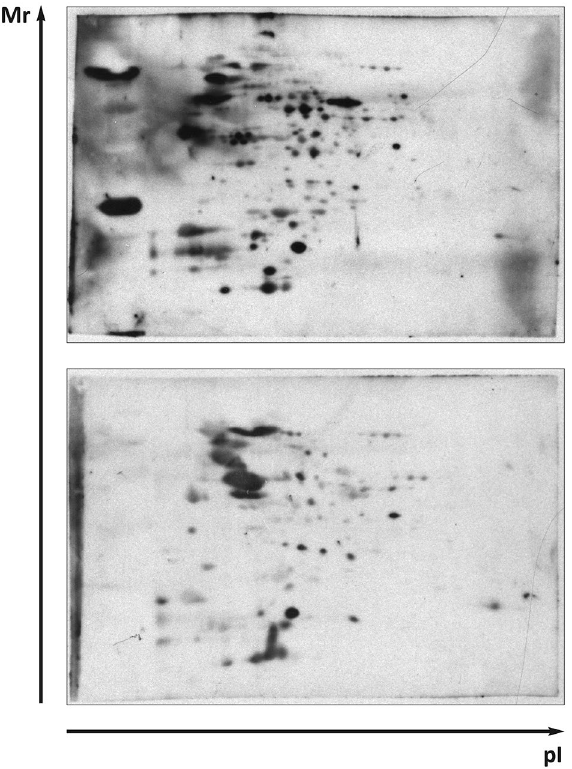
Figure 2. Western blot analysis to evaluate F. tularensis FSC200 whole-cell lysate protein targets recognized by sera from F. tularensis FSC200 infected Balb/c mice and detected by chemiluminescence. The 2-D reference immunoblots demonstrated the reaction of antibody clones in murine sera obtained from Balb/c GF (upper) and SPF (bottom) mice at 12 h post infection. A total 200 μg of protein was separated by immobilized pH gradient (IPG) strips (3–10) and 12% (w/v) SDS-PAGE gels. Polyclonal peroxidase-conjugated goat anti- mouse IgG antibody was used for secondary antibody detection. All experiments were performed in biological triplicates (individual sera) for all time intervals and were independently repeated at least three